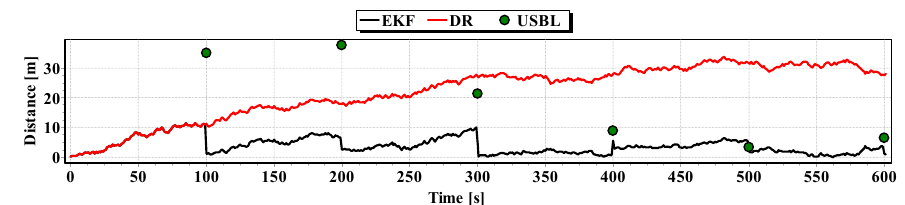
Figure 27. Graph of the reference position distance from the position estimated by EKF and DR methods and determined by the USBL system (single passage).